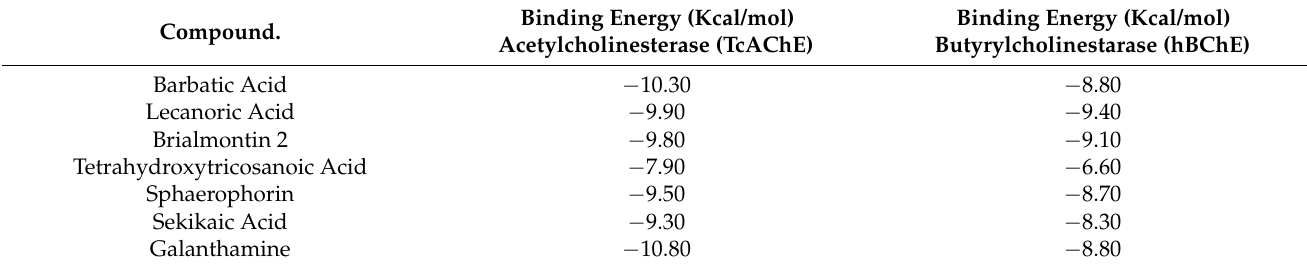
Table 6. Binding energies resulting from molecular docking experiments of the selected compounds in the extracts of Lecania brialmontii , Pseudephebe pubescens and Sphaerophorus globosus , together with the standard inhibitor galantamine on acetylcholinesterase (TcAChE) and butyrylcholinesterase, (hBChE).